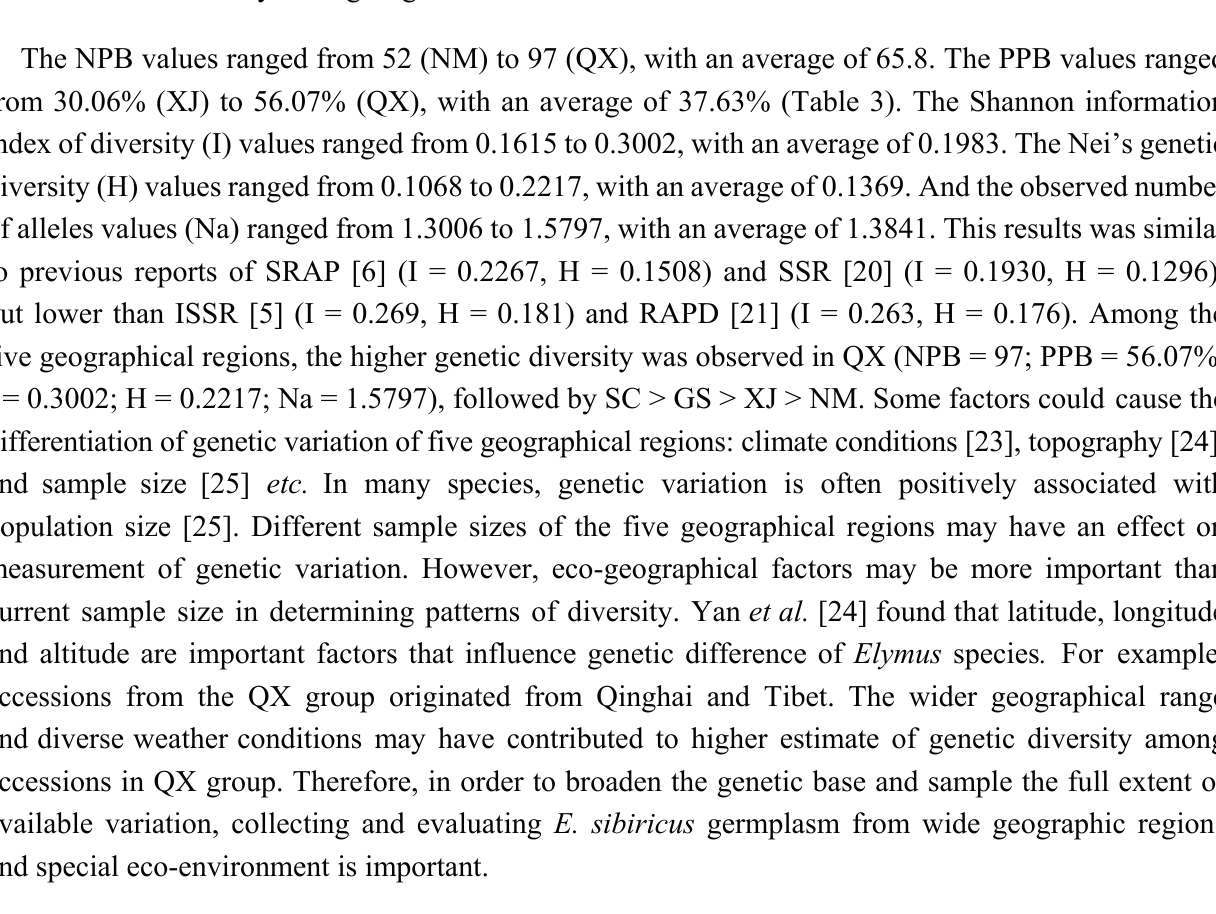
Table 3. Genetic variability within five geographic regions of E. sibiricus detected by SCoT